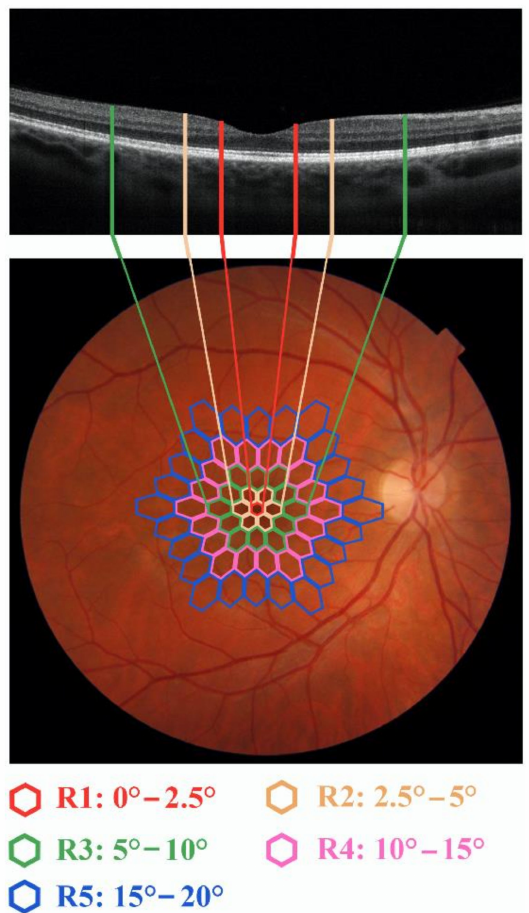
Figure 1. Fundus image from a representative Control (right eye) superimposed by the multifocal electroretinogram (mfERG) stimuli, provided by 61-scaled hexagons array subtending 20 degrees of the visual field. In the mfERG ring analysis we considered five rings, depicted in different colors, with increasing eccentricity from the fovea: from 0 to 2.5 degrees (ring 1, R1 in red), from 2.5 to 5 degrees (ring 2, R2 in brown), from 5 to 10 degrees (ring 3, R3 in green), from 10 to 15 degrees (ring 4, R4 in pink) and from 15 to 20 degrees (ring 5, R5 in blue). The central 3 mm (enclosed in the green bars) of a 6 mm macular line scan, obtained by Spectral domain-Optical Coherence Tomography (Sd-OCT), assesses the morphology of retinal structures enclosed in almost the 10 degrees of eccentricity from the